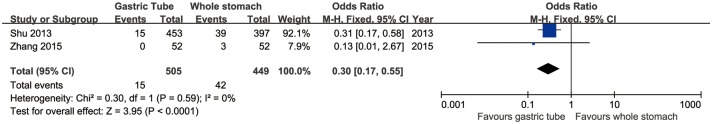
Forest plot of thoracic stomach syndrome in the whole-stomach and gastric-tube groups.